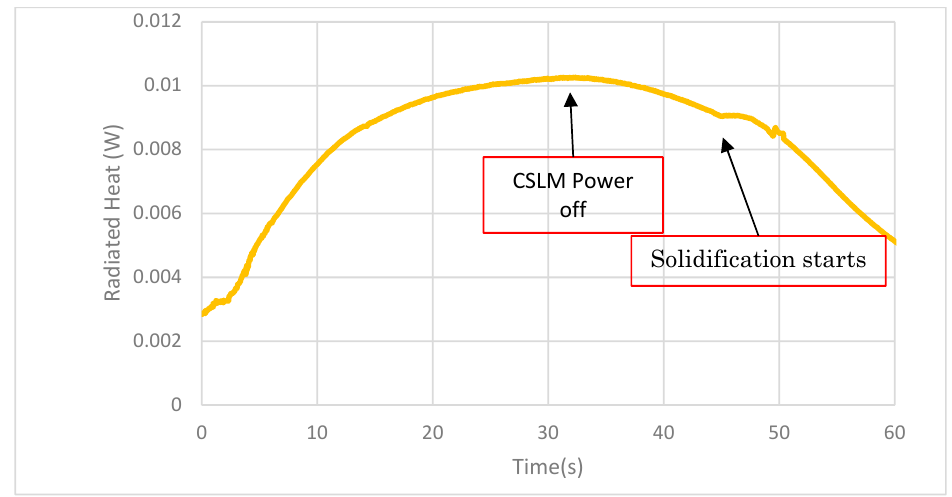
Figure 7. Radiant heat with time taken from the surface of a sample solidified in a N 2 atmosphere.